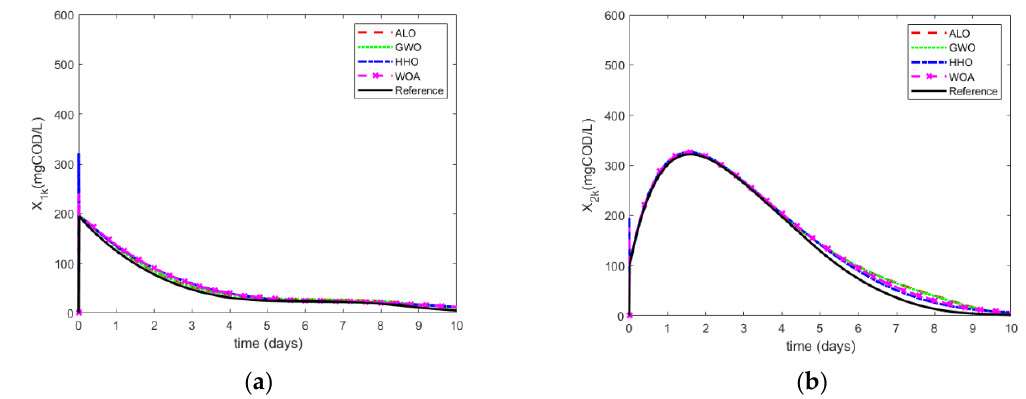
Figure 9. Tracking performance comparison in presence of parameter uncertainty: ( a ) X 1, k and ( b ) X 2, k .